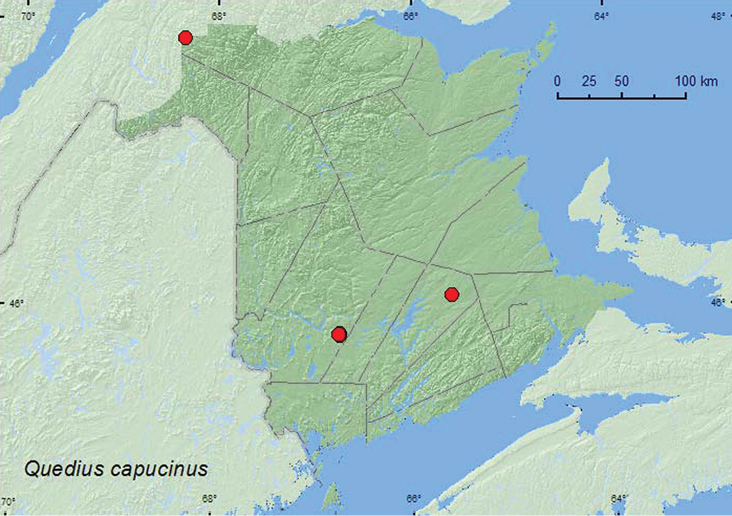
Collection localities in New Brunswick, Canada of Quedius capucinus.